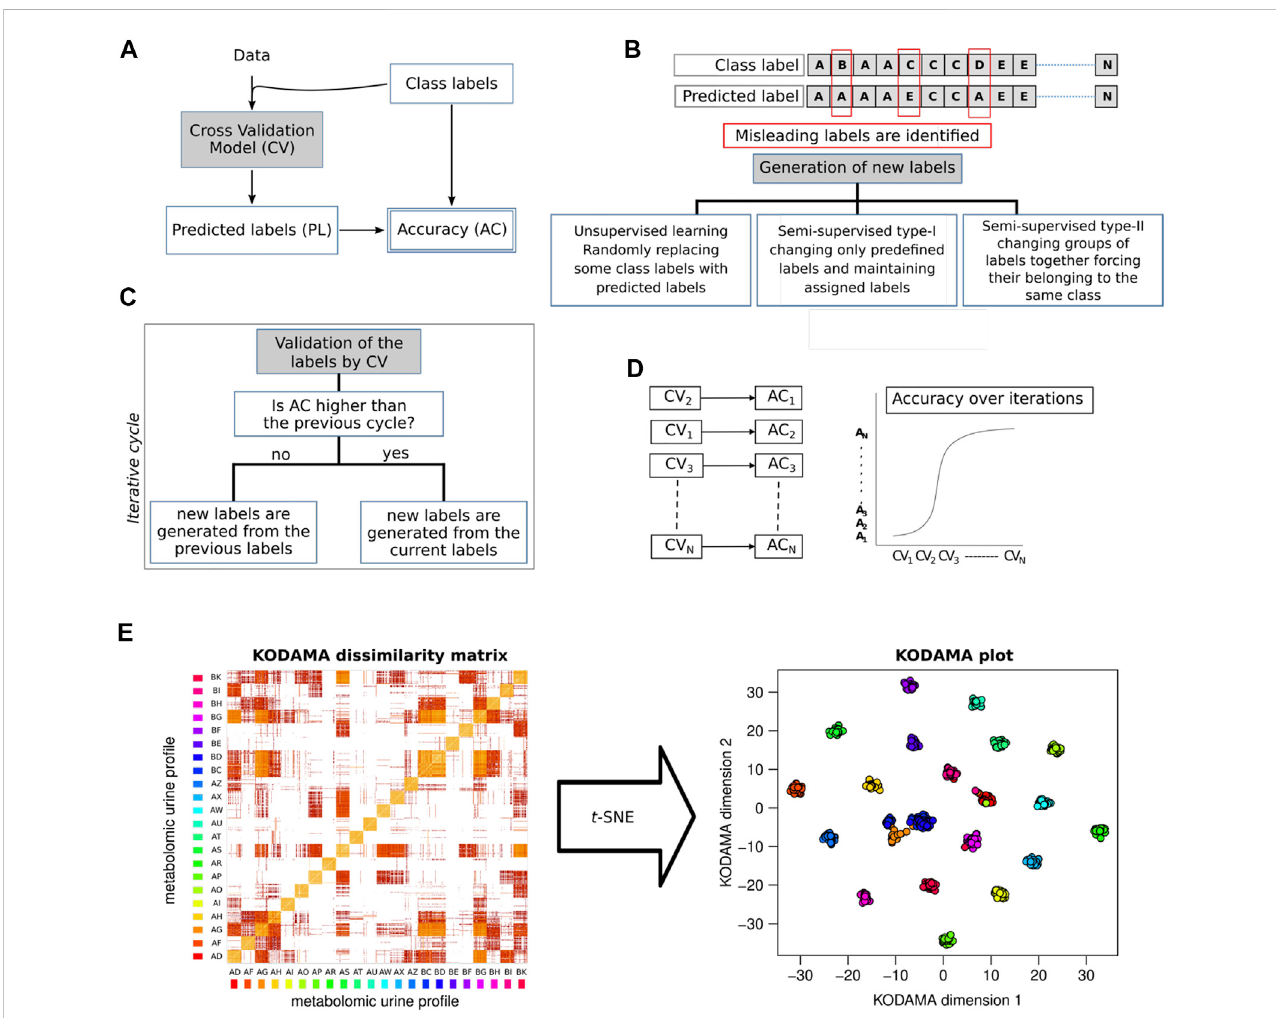
FIGURE 2 KODAMAaccuracymaximizationbyiterativecross-validations. (A) Cross-validationmodel(CV)generatespredictedlabels(PLs)thatareusedtocalculate theaccuracyvalue(AC). (B) Generationofnewlabelstoconducttheprocessofaccuracymaximizationcanbei)anunsupervisedmethod,randomlyswapping some class labels of misleading samples with predicted labels; ii) semi-supervised type-I, changing only prede fi ned labels and maintaining assigned class labels; or iii) semi-supervised type-II, changing groups of labels together forcing their belonging to the same class. (C) Generation of new labels is an iterative process aimed to identify the labels with the highest cross-validated accuracy. (D) Accuracy values increase with the number of iterations. (E) KODAMA dissimilarity matrix generated as output can be transformed with MDS, or t -SNE, in a low-dimensional